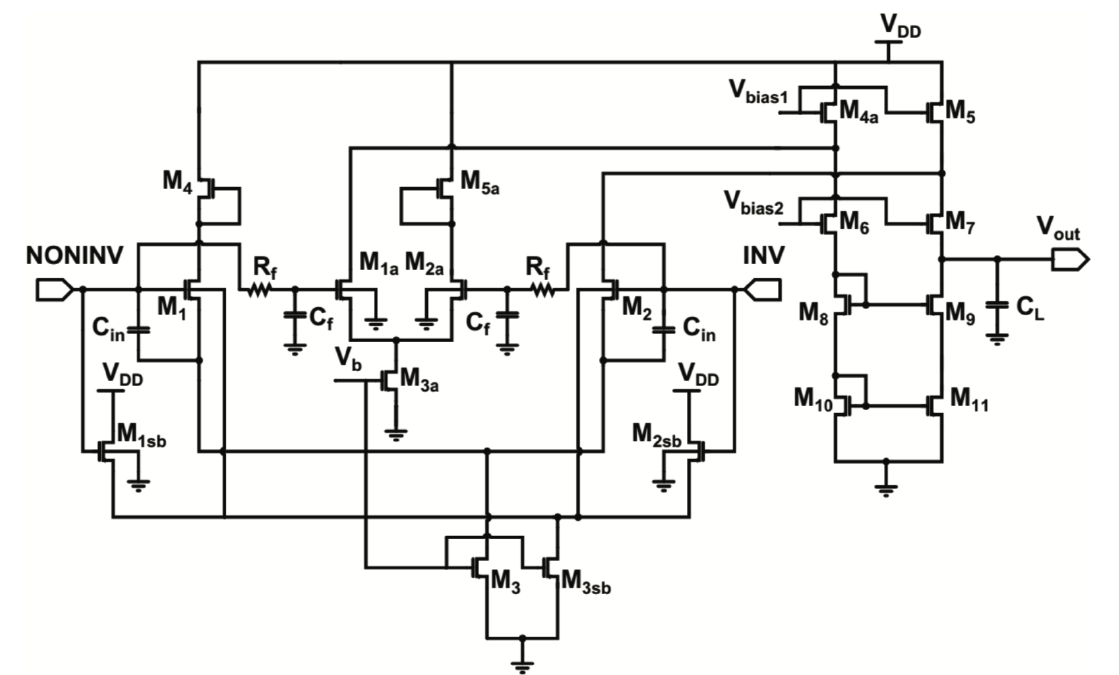
Figure 9. Source-buffered folded cascode amplifier with replica circuit and RC (resistor–capacitor) filter.